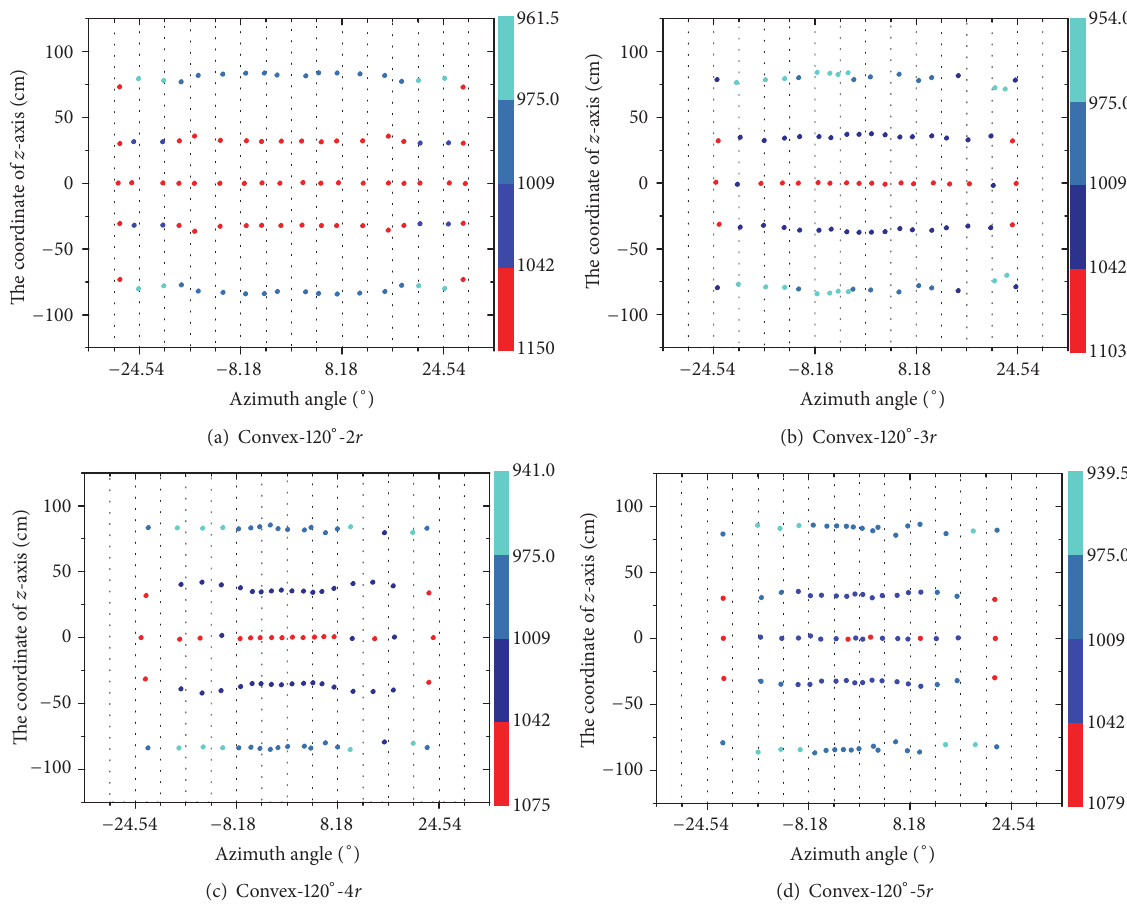
Figure 12: The spatial distributions of fragment corresponding to convex structures.